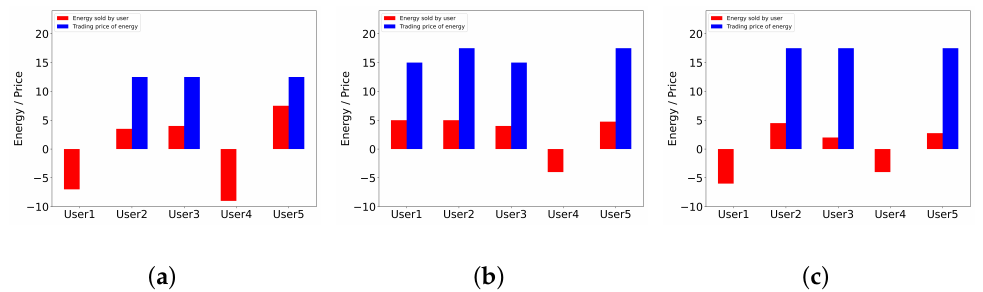
Figure 7. Agent’s decisions at different time-slots: ( a ) demand over supply ( H = 4); ( b ) supply over demand ( H = 18); ( c ) balance state ( H = 21).